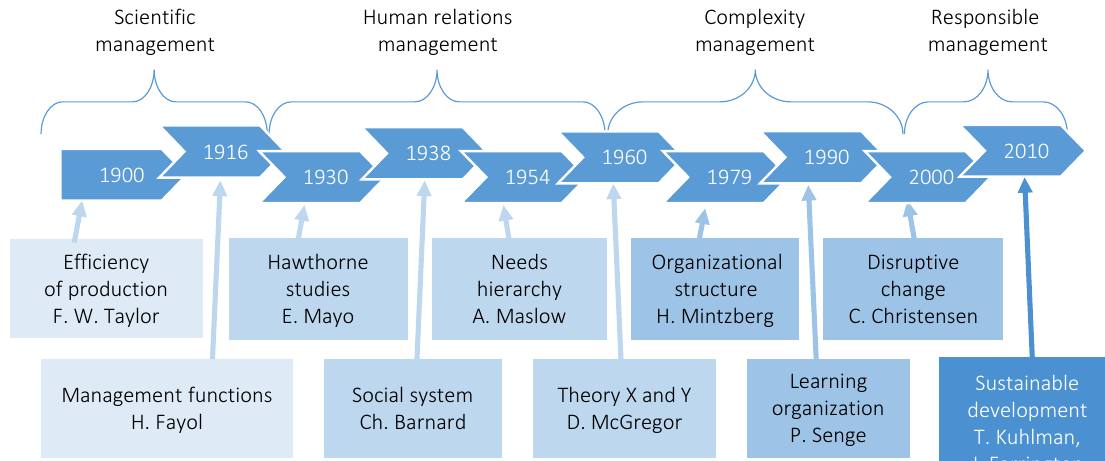
Figure 1. Evolution of management